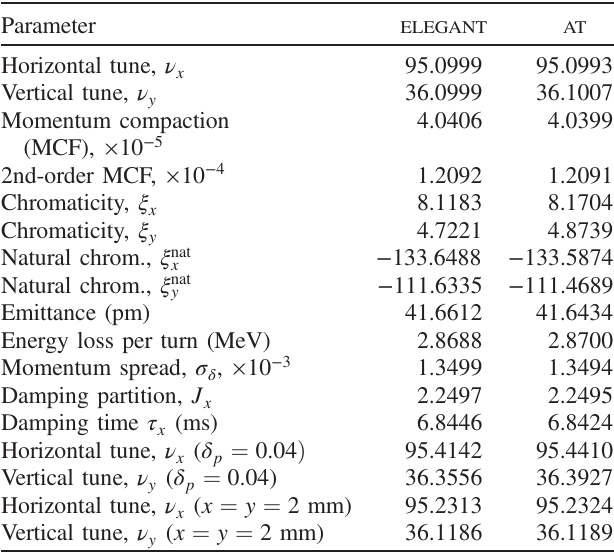
TABLE III. APS-U lattice parameters calculated with ELEGANT and AT .